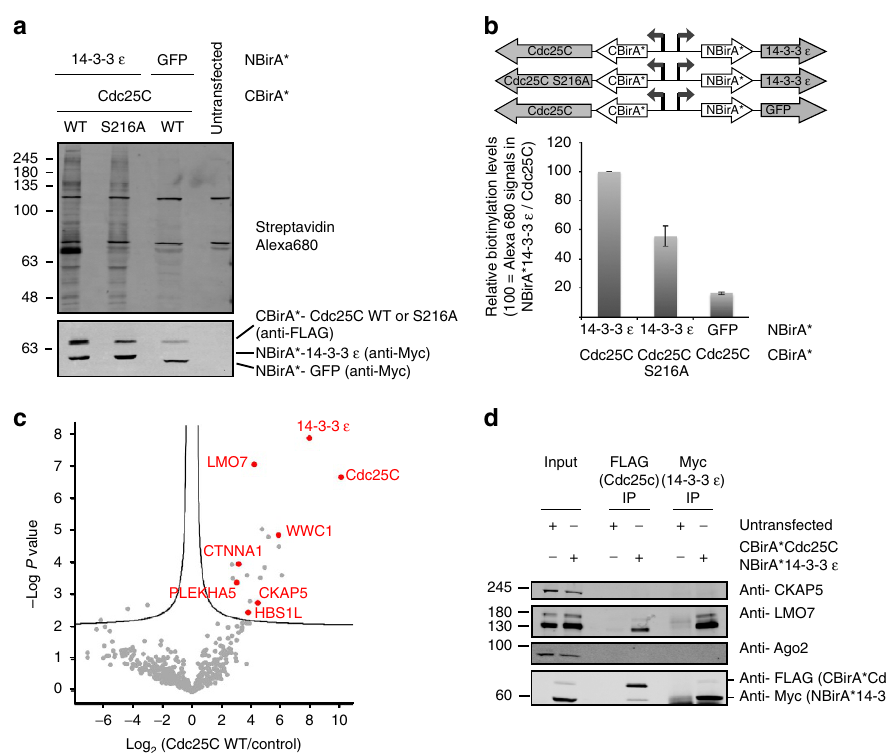
Figure 3 | Application of split-BioID to a physiological phosphorylation-dependent PPI. ( a ) Blots of lysates of cells transiently expressing NBirA*-14-3- 3 e /CBirA*-Cdc25c (WTor S216A), or NBirA*-GFP/CBirA*-Cdc25c WTas a control. ( b ) Quantitative analysis of a performed as described in Fig. 2c (error bars, s.d.; n ¼ 3 independent experiments). ( c ) Volcano plot showing proteins enriched in the Cdc25C WTover the control BioID samples from stable cell lines. The logarithmic ratios of protein LFQs were plotted against negative logarithmic P values of a two-sided two samples t -test. The hyperbolic curve delimitate significantly enriched proteins from common hits (FDR r 0.07, n ¼ 3). Hits that showed higher LFQs than in the GFP and the Cdc25C S216A samples are indicated in red. ( d ) Validation co-IP experiments from HeLa cell lysates transfected with myc-NBirA*-14-3-3 e and FLAG-CBirA*-Cdc25C or lysates of untransfected cells as a control. Endogenous LMO7 is detected in both FLAG and Myc IPs from transfected cells while endogenous CKAP5 is not.